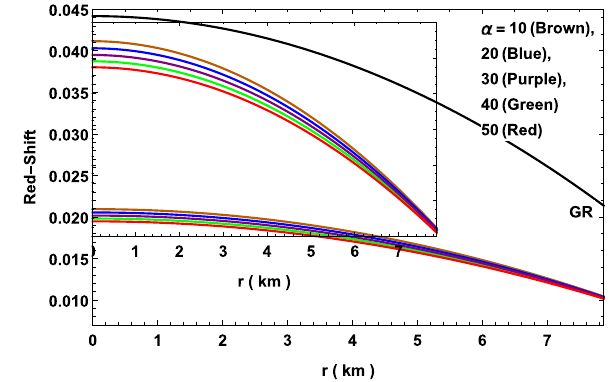
Fig. 3 Variation of pressures for 4U 1538-52 using the parameter pro- vided in Table 1